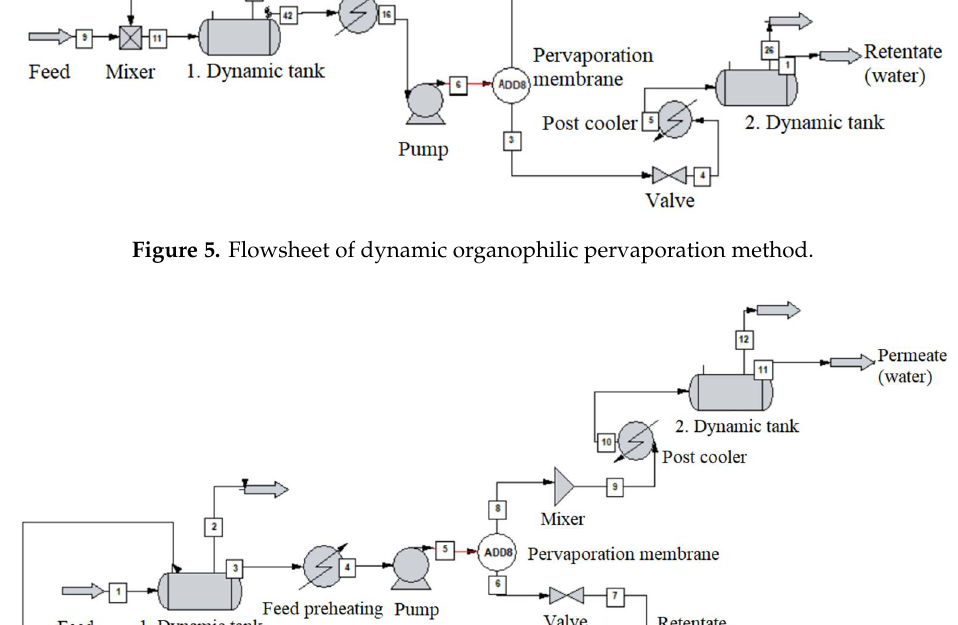
Membranes 2020 , 10 , x FOR PEER REVIEW Figure 6. Flowsheet of dynamic hydrophilic pervaporation method. Figure 6. Flowsheet of dynamic hydrophilic pervaporation method. Figure 6. Flowsheet of dynamic hydrophilic pervaporation method.